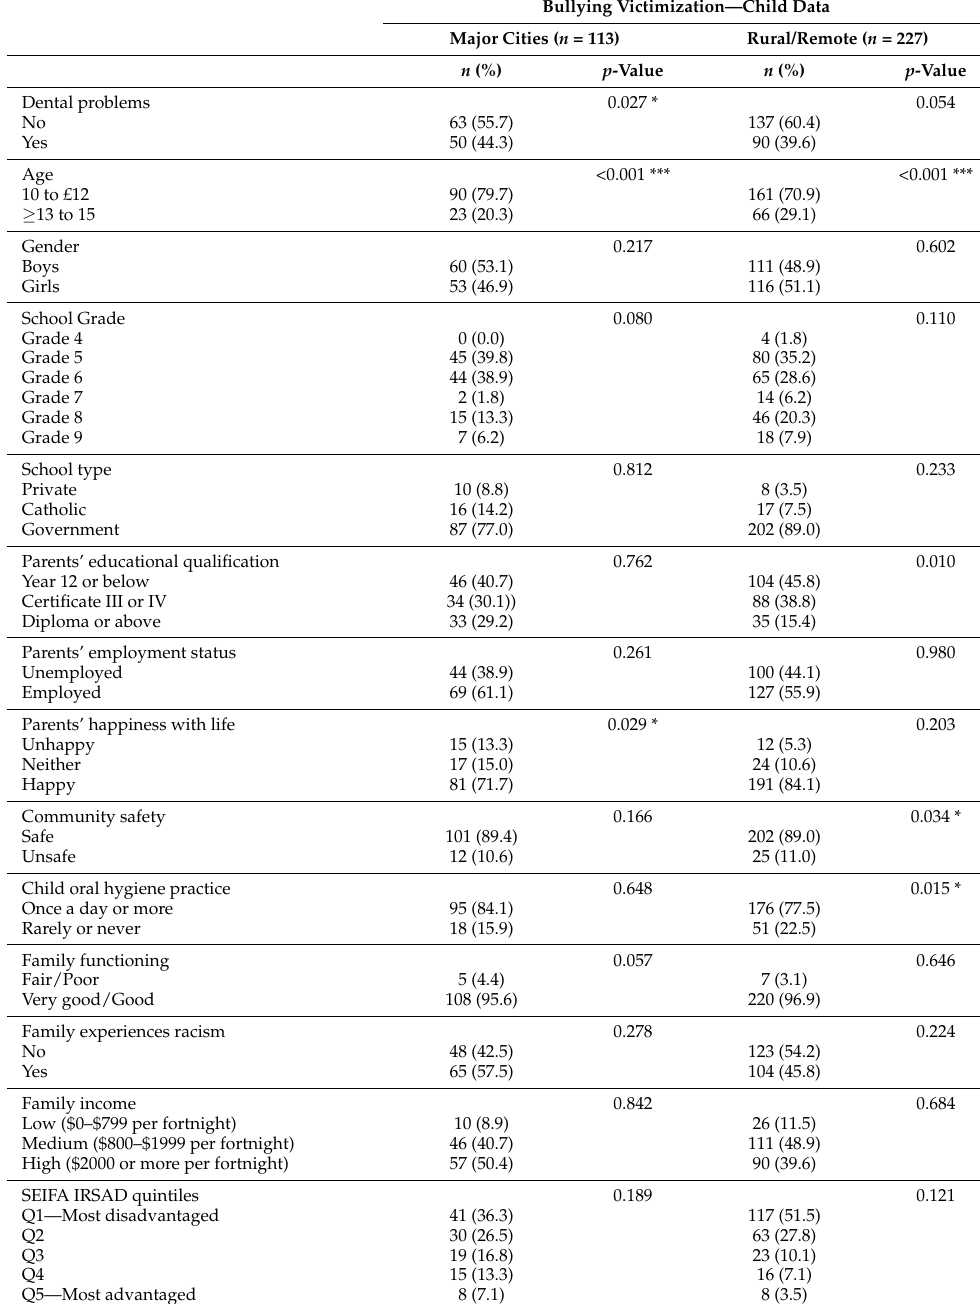
Table 4. Bivariate relationship between explanatory variables and bullying victimization by remoteness—Child